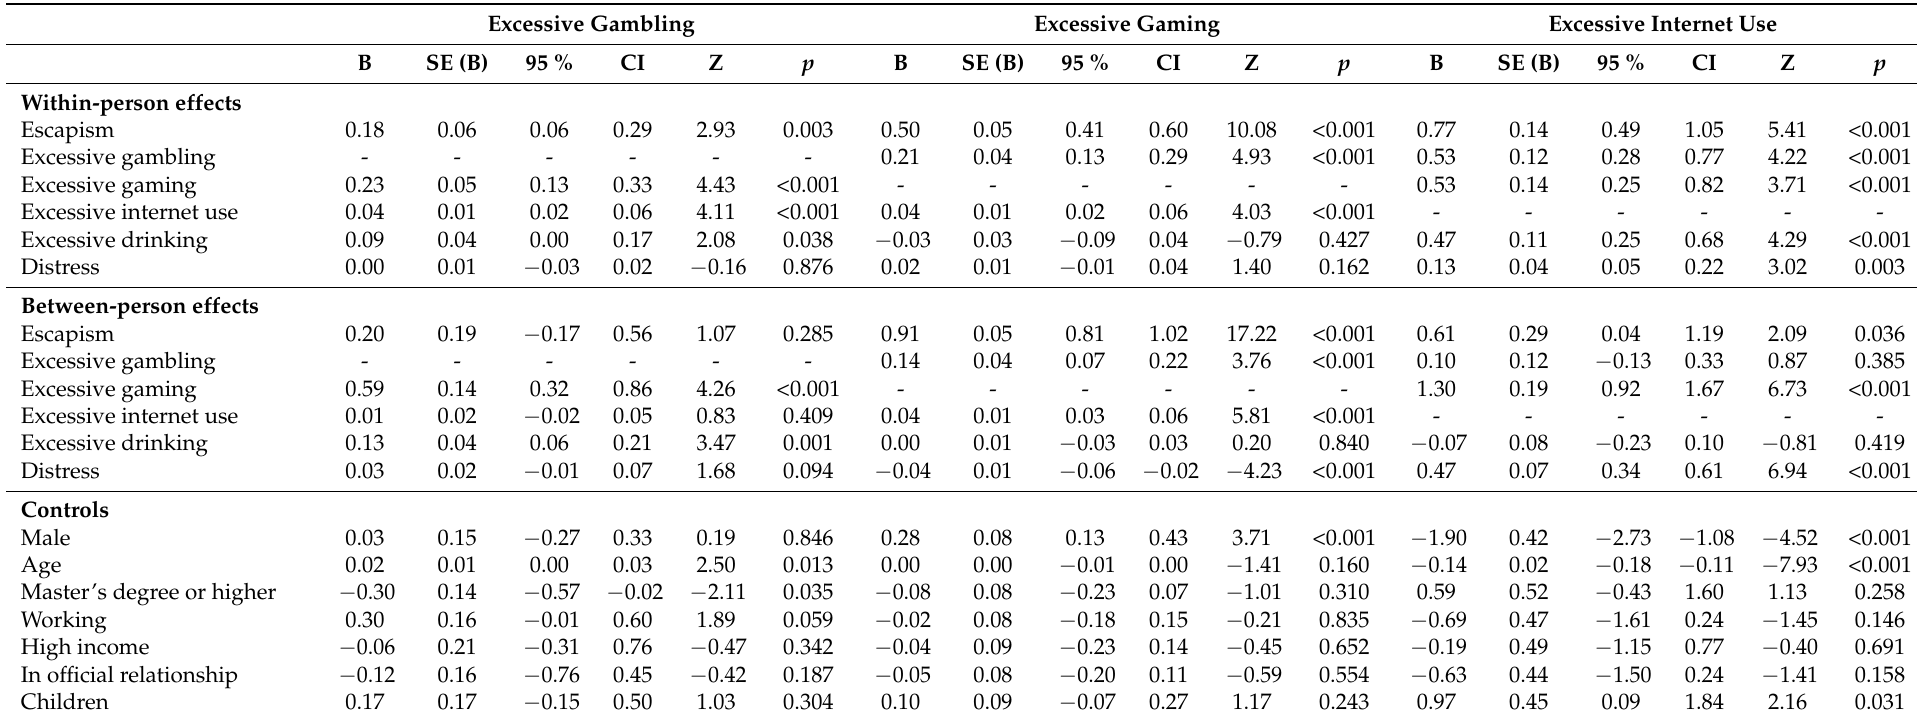
Table 2. Hybrid models showing within-person and between-person effects on excessive online